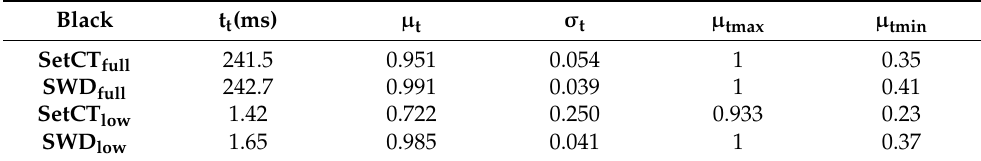
Table 2. Performance evaluation of the THz-FDS classification of a black sample.